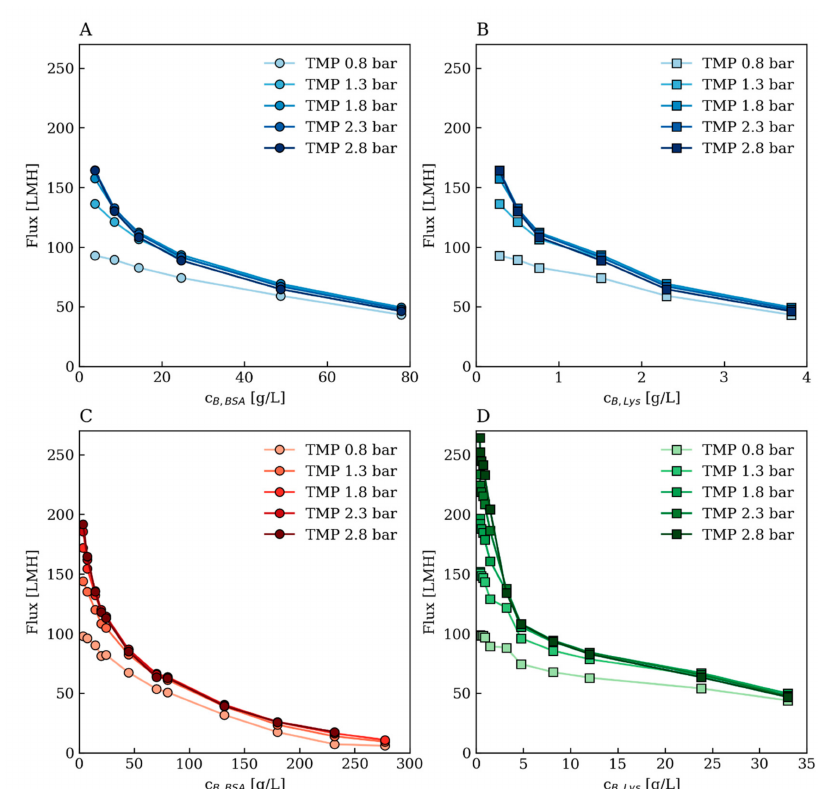
Figure A2. Training data sets including di ff erent protein concentrations, TMP at CF 200 mL / min. ( A , B ) Multi-component training set containing BSA and lysozyme (blue) in the same solution and one component solution of ( C ) BSA (red) and ( D ) lysozyme (green). Figure A3 gives the correlation curve to calculate R Lys from the UV absorbance at 280 nm using Equation (2). The curve was calculated using the lysozyme training data (Table A1, Training set 2) and exhibits a correlation coe ffi cient of 0.97.